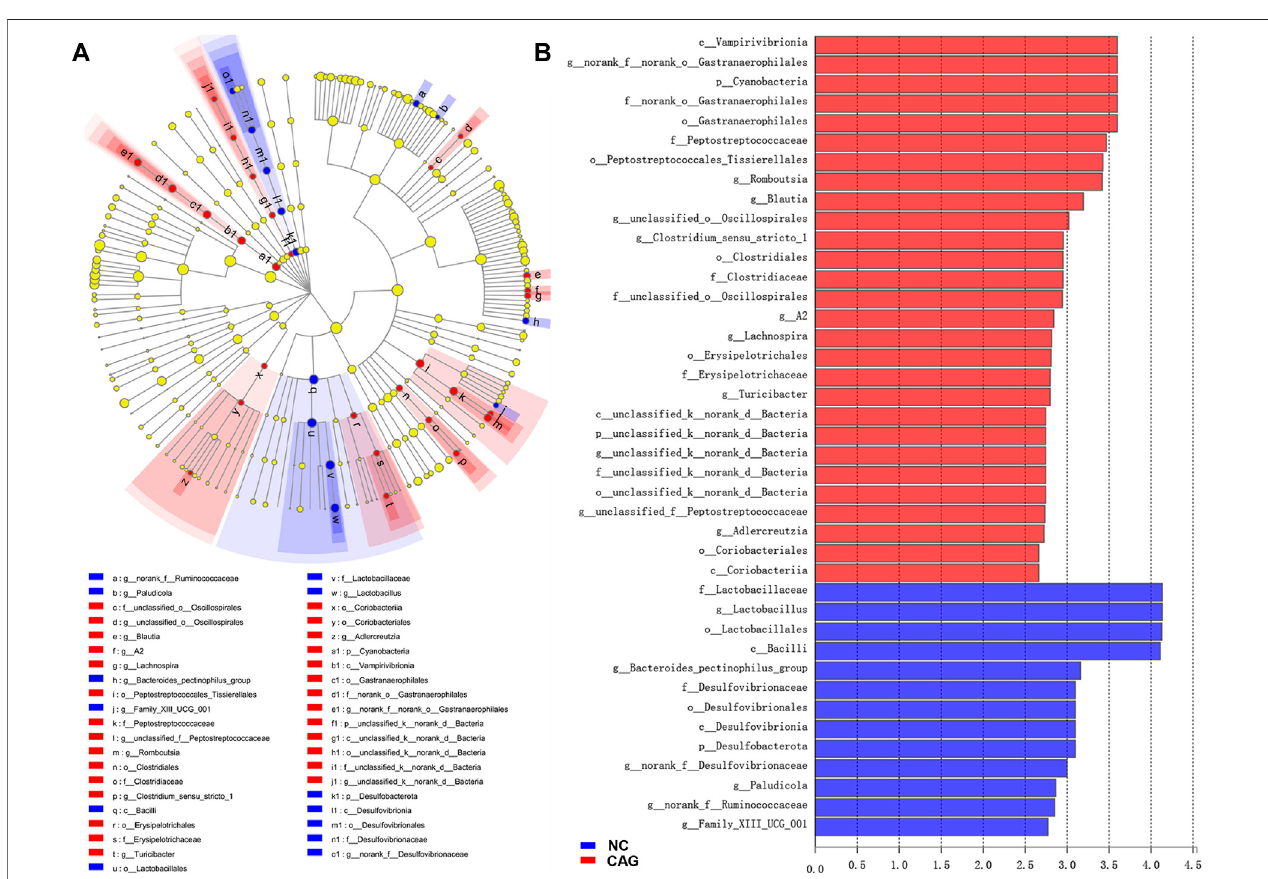
FIGURE 6 | LEfSe analysis of rat intestinal microbiota in NC and CAG groups. (A) LEfSe multilevel species tree diagram with inside-out circle nodes representing taxonomiclevelsfromthephylumleveltogenuslevel;eachsmallcirclerepresentsataxonunderthattaxonomiclevel.Thelightyellowcirclenodesindicatemicrobialtaxa thatarenotsigni fi cantlydifferentinanyofthedifferentgroupings.Theredandbluecirclenodesindicatemicrobialtaxathatweresigni fi cantlyenrichedintheNCandCAG groups, respectively, and had a signi fi cant effect on the difference between groups. (B) LDA discriminant bar graph of LDA scores obtained by LDA analysis, with larger LDA scores representing a greater effect of species abundance on the difference